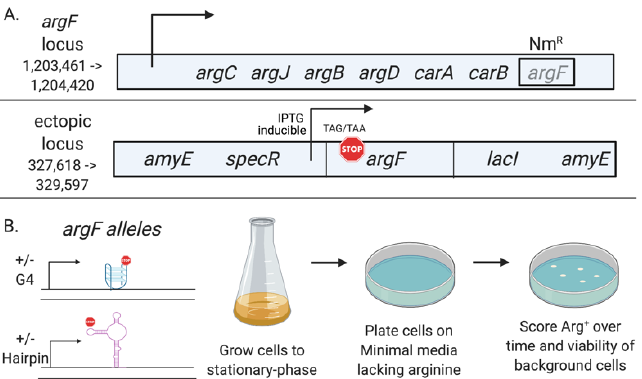
Figure 1. Schematic of the stationary-phase assay. ( A ) The argF gene was replaced with a selectable neomycin marker at its chromosomal locus. Then, IPTG-inducible argF alleles containing nonsense codons and differing in their potential to form non-B DNA structures were introduced into an ectopic chromosomal region. ( B ) Stationary-phase mutagenesis assay. Cells are grown to stationary phase and plated on minimal media lacking arginine. Then, we scored Arg + mutants over time.